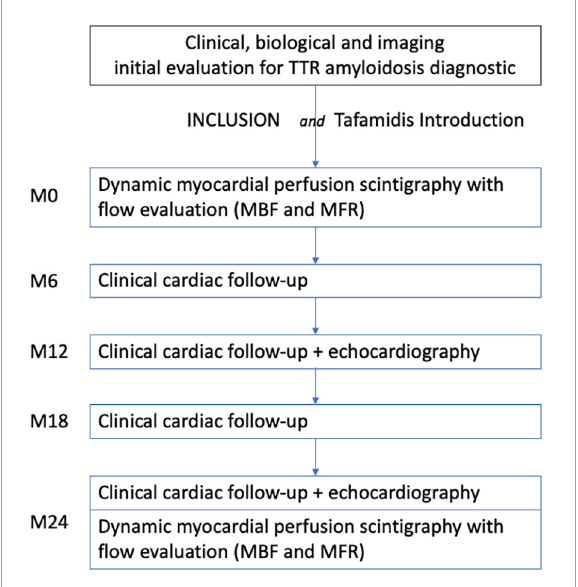
FIGURE1 Flow of the participants throughout the study. MBF, Myocardial Blood Flow; MFR, Myocardial Flow